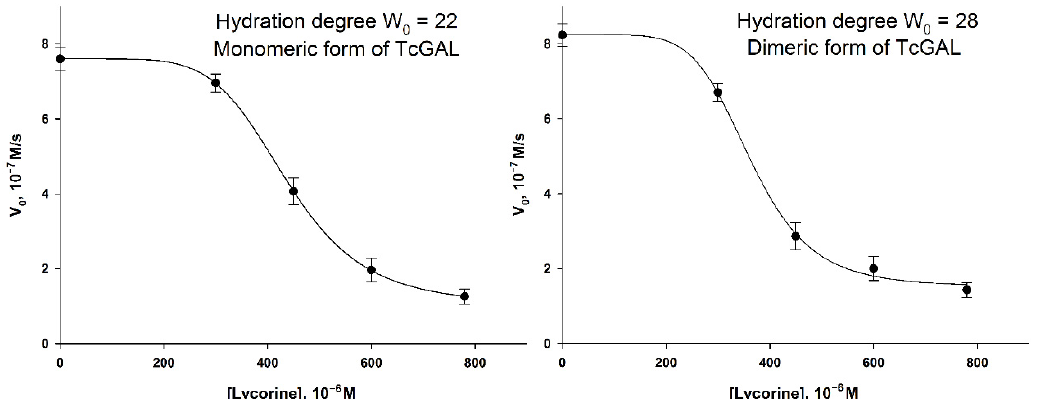
Figure 8. The inhibition of TcGAL by lycorine at hydration degrees W 0 = 22 and W 0 = 28. The concentration of TcGAL was 3.5 × 10 − 5 M. The concentration of D-arabinono-1,4-lactone was 1 mM. Values are presented as the mean ± SD of three experiments.